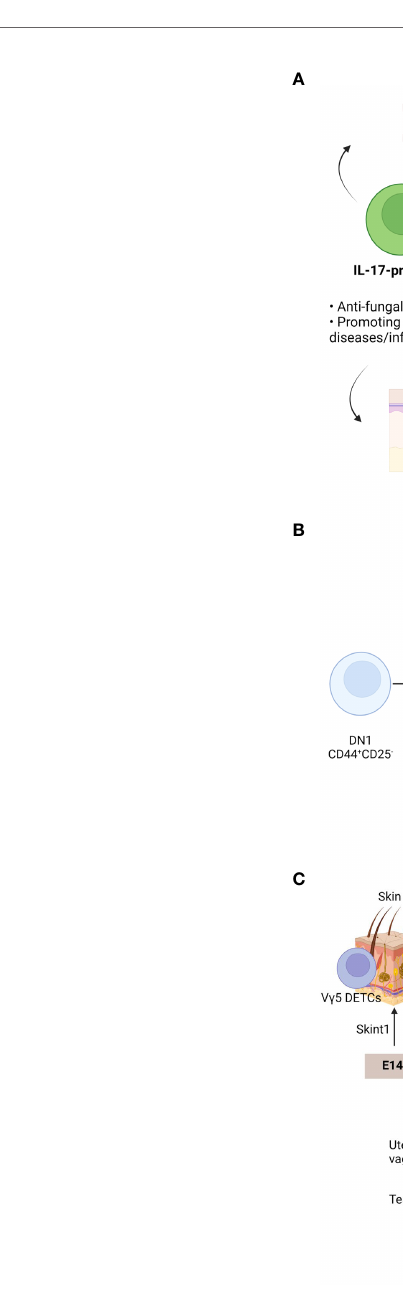
FIGURE 1 | Characteristics and development of gd T cells. (A) gd T cell subsets are heterogenous. Functionally, gd T cells can be divided into two groups: one is IL-17- producing cells and the other is IFN- g -producing cells. IL-17-producing cells are commonly antifungal cells or promoting autoimmune diseases and in fl ammation. IFN- g - producing cells are usually antiviral or anti-tumoral cells. Both subsets can be further divided by circulation ability. Although the majority of gd T cells are tissue-resident cells in the mucosal barriers, some gd T cells can circulate body. (B) T cell development occurs in the thymus. T cell development can be divided by expression of CD44 and CD25 (DN1: CD44+CD25-; DN2: CD44+CD25+; DN3: CD44-CD25+; DN4: CD44-CD25-). Although DN2 or DN3 cells can be gd T cells, commitment usually occurs after DN3 stage. Strong TCR signal enhances gd T cell fate. DN4 ab T cells become CD4+CD8+ DP cells. By their interaction with MHC class I or MHC class II, DP cells become a CD8 T cells or CD4 T cells, respectively. gd T cells can be IFN- g -producing cells by strong TCR signal. On the other hand, weak TCR signaling induces IL-17- producing cells. (C) Different gd T cell subsets can be generated in the fetal thymus. At embryonic (E) 14, V g 5+ dendritic epidermal T cells (DETCs) are generated and migrate into the skin epidermis. SKINT1 is important for V g 5+ DETC development and selection. At E16.5, V g 6+ cells can be developed. These cells migrate into the multiple organs such as uterine, vagina, testis, lung, or meninges. They become a tissue-resident cells in those tissues. Cognate ligand for their TCR is not identi fi ed. At E17.5, IL-17-producing V g 1/4+ cells are made. They can migrate into the skin dermis, lung, or liver. They are also tissue-resident cells. Although several factors have been known for their development, cognate TCR ligand is not identi fi ed. After E18, V g 7+ intraepithelial cells (IELs) are generated. They migrate into the gut and become gut- resident cells. BTNL proteins are critical for development and maintenance of V g 7+ IELs. After birth, V g 1/4+ cells are further generated. They can circulate and are observed in the blood or lymphoid